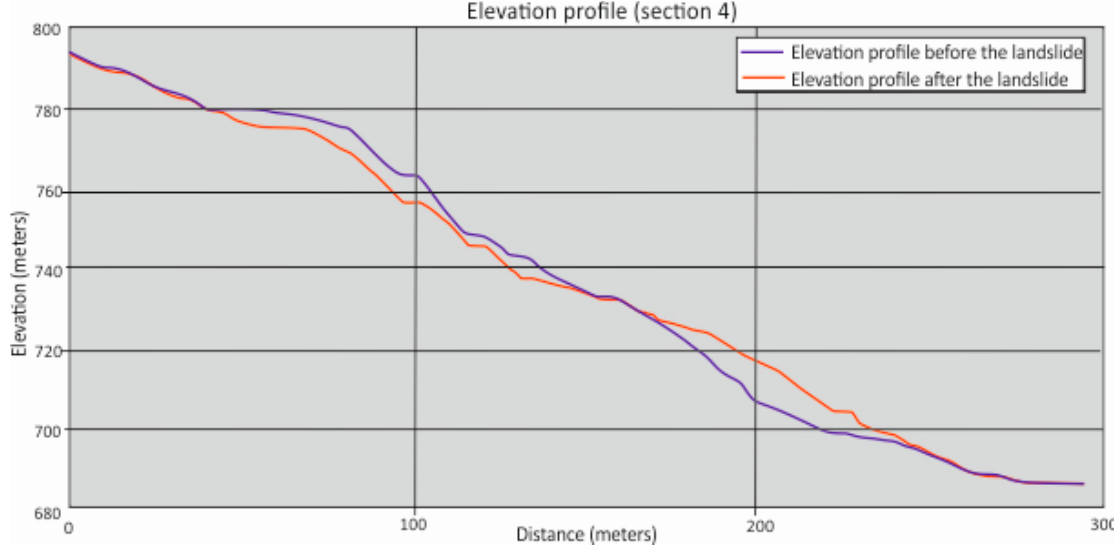
Figure 13. Elevation profiles of section 4 in Figure 11.